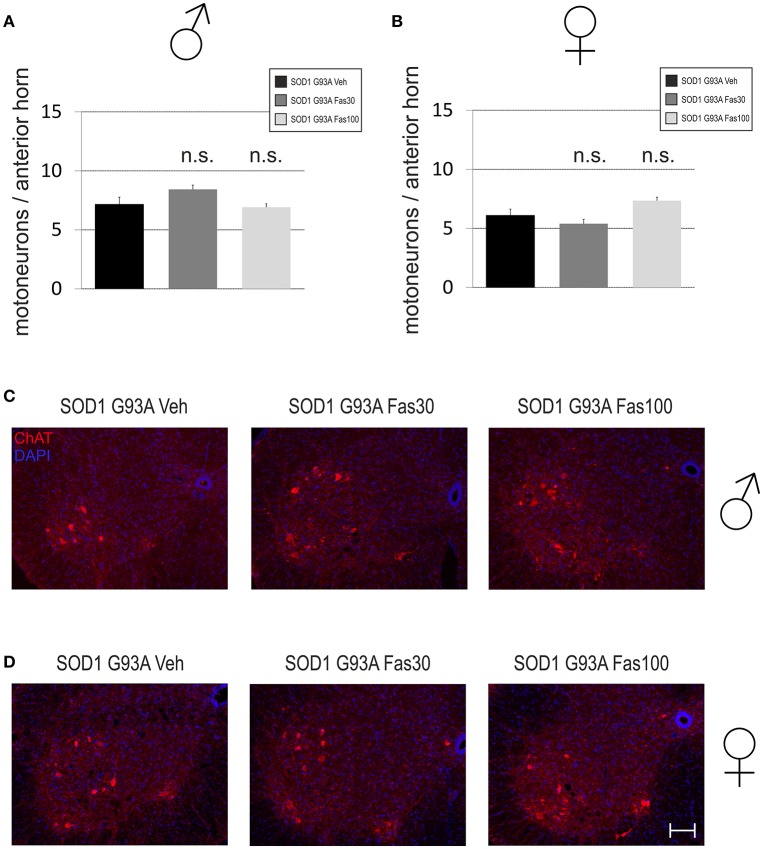
Motoneuronal survival in the spinal cord in end-stage stage SOD1G93A transgenic mice. (A,B) Numbers of ChAT-immunopositive motoneurons (MN) per section in the spinal cord anterior horn of female (Fas30 n = 3, Fas100 n = 3, Veh n = 3) and male (Fas30 n = 3, Fas100 n = 3, Veh) mice treated with 30 mg/kg Fasudil (Fas30), 100 mg/kg Fasudil (Fas100), or with vehicle (Veh). (C,D) Representative micrographs of ChAT-immunopositive MNs in the spinal cord anterior horn of female (C) and male (D) mice. [ChAT/Cy3 (red), DAPI (blue)]. Bars represent means ± SEM. Scale bar: 100 μm.